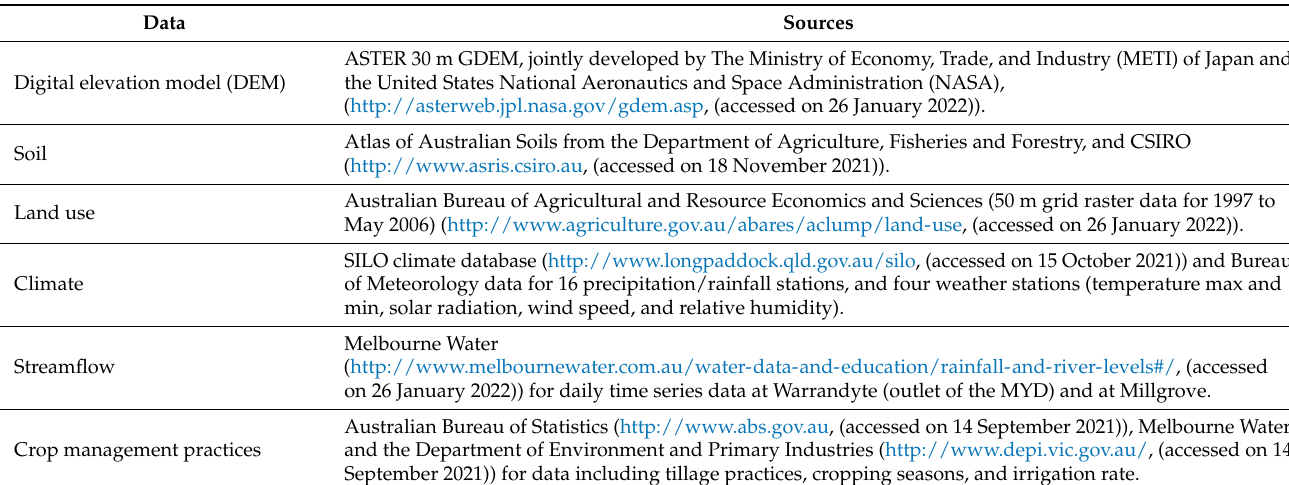
Table 1. Data sources for the SWAT